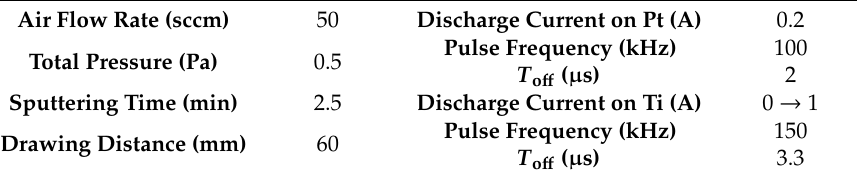
Table 1. Main deposition conditions of the